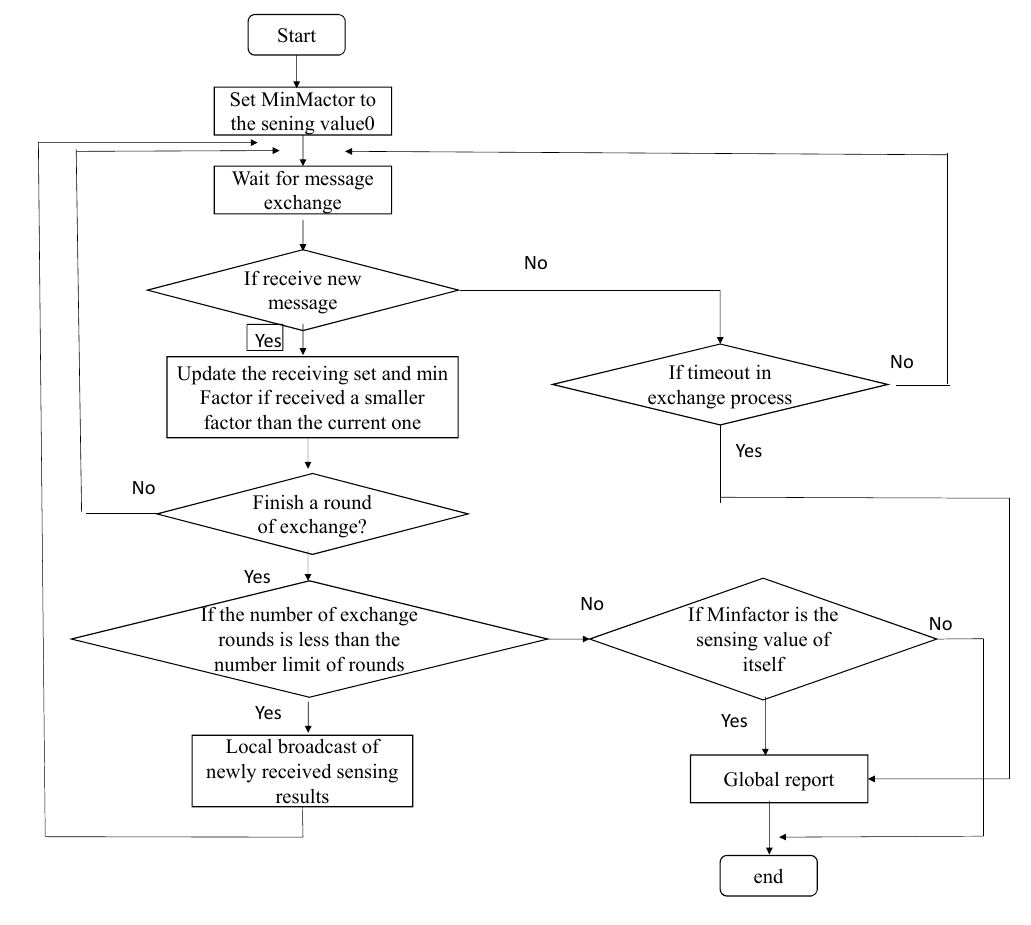
Figure 3. Flowchart of the proposed scheme.